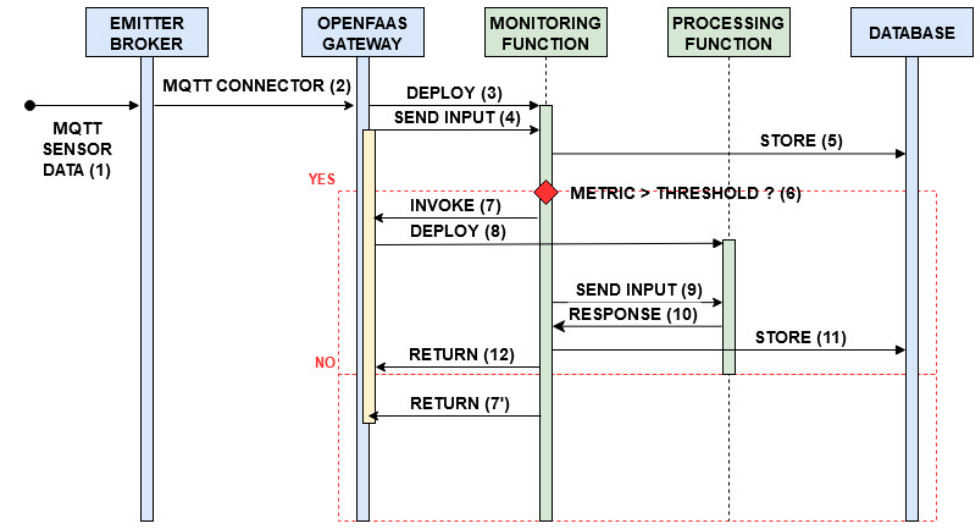
Figure 4. Sequence diagram for data monitoring and processing.